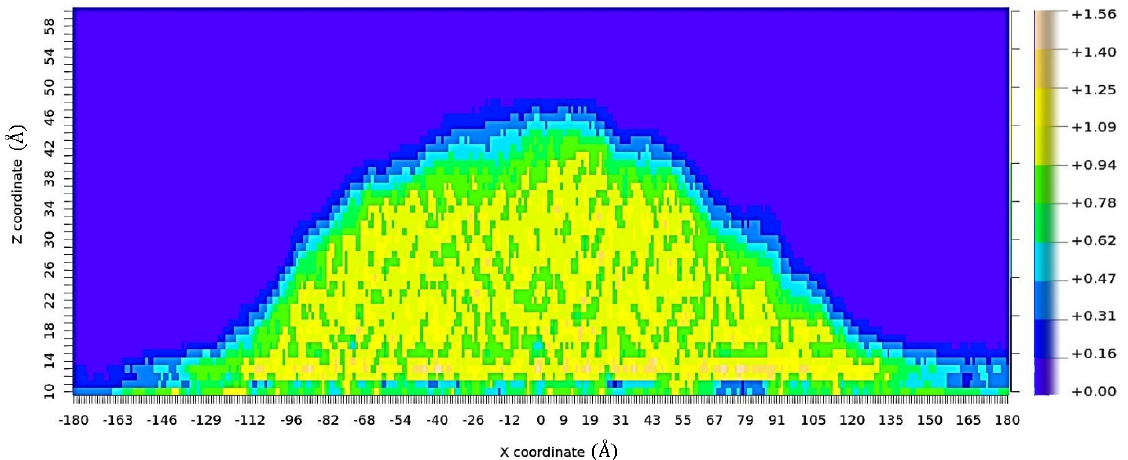
Figure 13. Density map showing density values for the 1 Å × 1 Å grid in g/cc for a difunctional epoxy system on the aromatic surface at 147 °C.